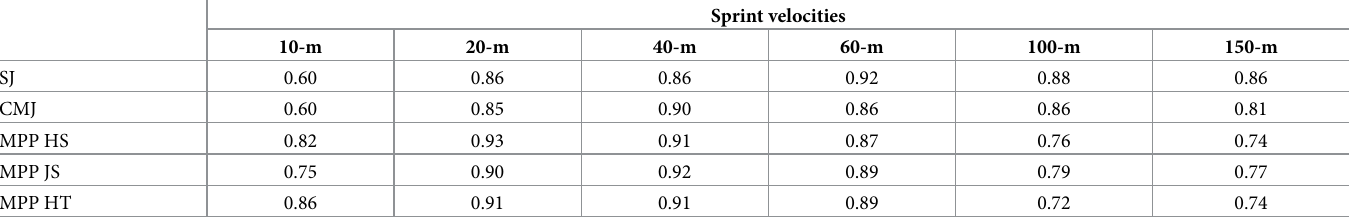
Table 2. Shared variance (R 2 ) of the relationships among the sprint velocities and the vertical jumps and the maximum mean propulsive power (MPP) in the differ- ent exercises in top-level sprinters and jumpers. Sprint velocities 10-m SJ 0.60